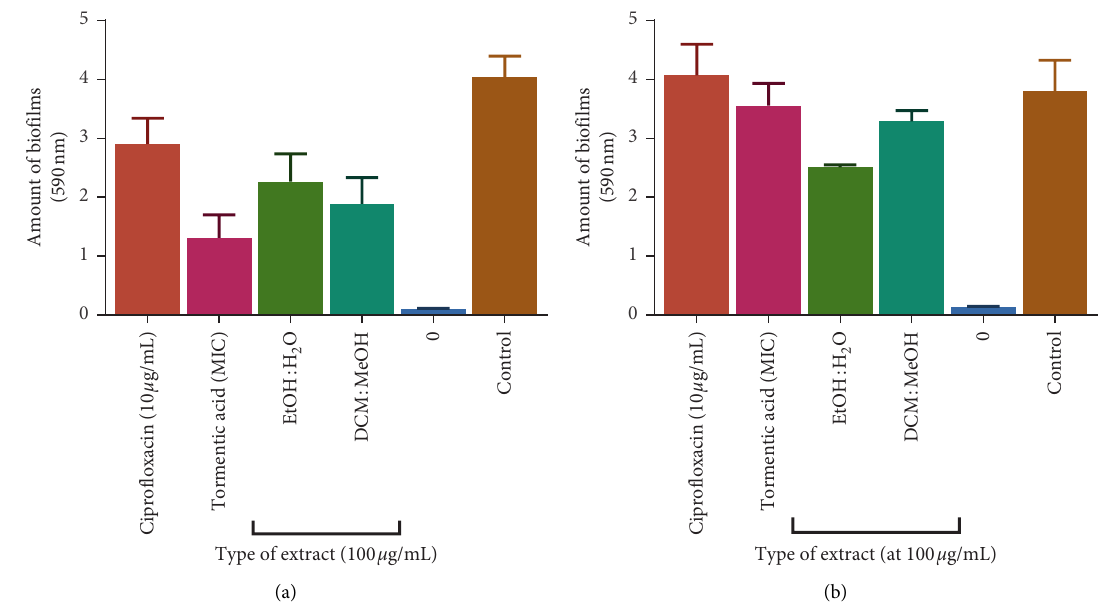
Figure 6: The effect of ciprofloxacin, tormentic acid congener, and C. viminalis extracts on biofilm detachment in S. pyogenes (a) and A. baumannii (b). Ciprofloxacin showed less effect on preformed biofilms than C. viminalis extracts and tormentic acid congener. Tormentic acid congener caused detachment of biofilms in S. pyogenes more than other agents, whilst the EtOH extract of C. viminalis had the greatest effect in A. baumannii